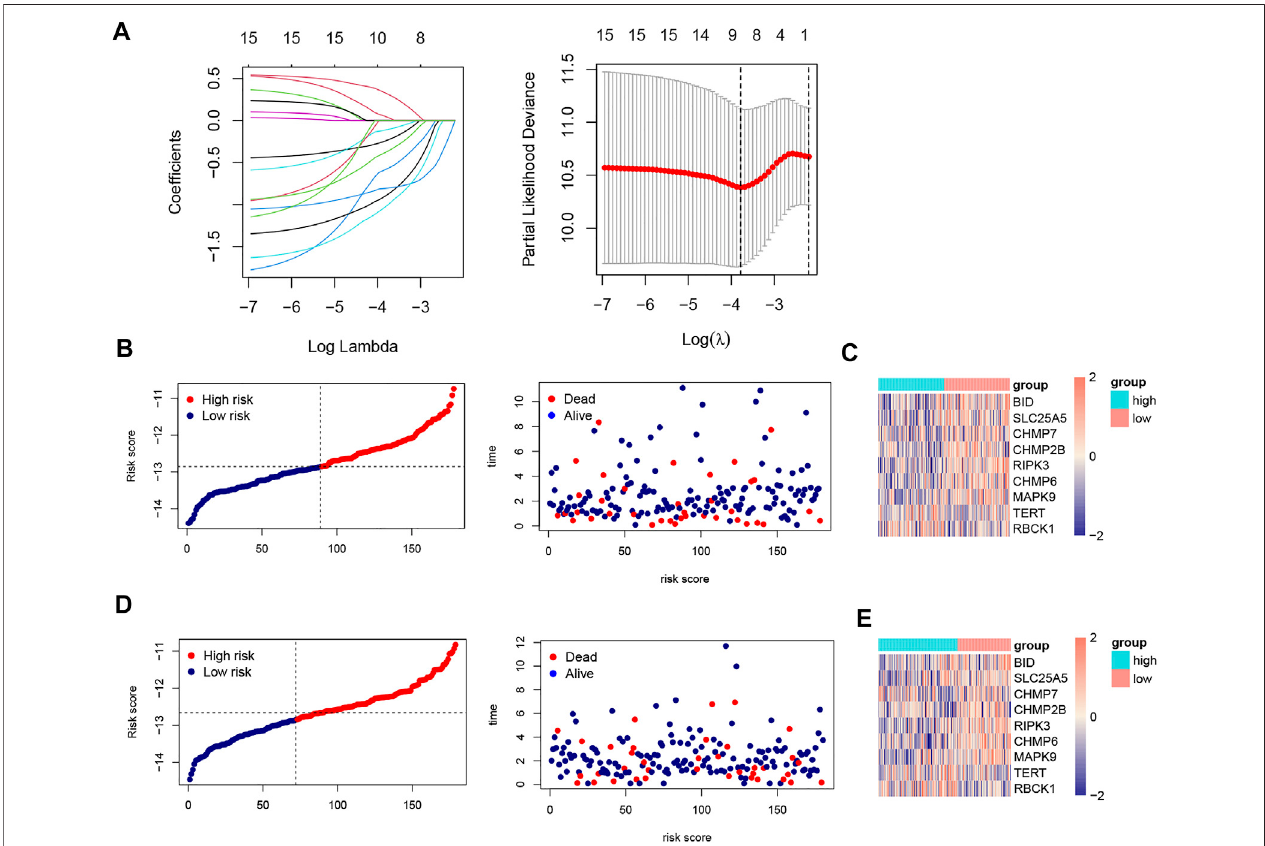
FIGURE4| LASSOanalysis,riskscoreplotsandexpressionof9NRGsintrainingandvalidationsets. (A). ConstructionofprognosticmodelbasedonLASSOCox analysis; (B) . The distribution of patients ’ survival times and survival status in training set; (C) . Heatmap of the expression matrix of 9 genes in training set; (D). The distribution of patients ’ survival times and survival status in validation set; (E) . Heatmap of the expression matrix of 9 genes in validation set.